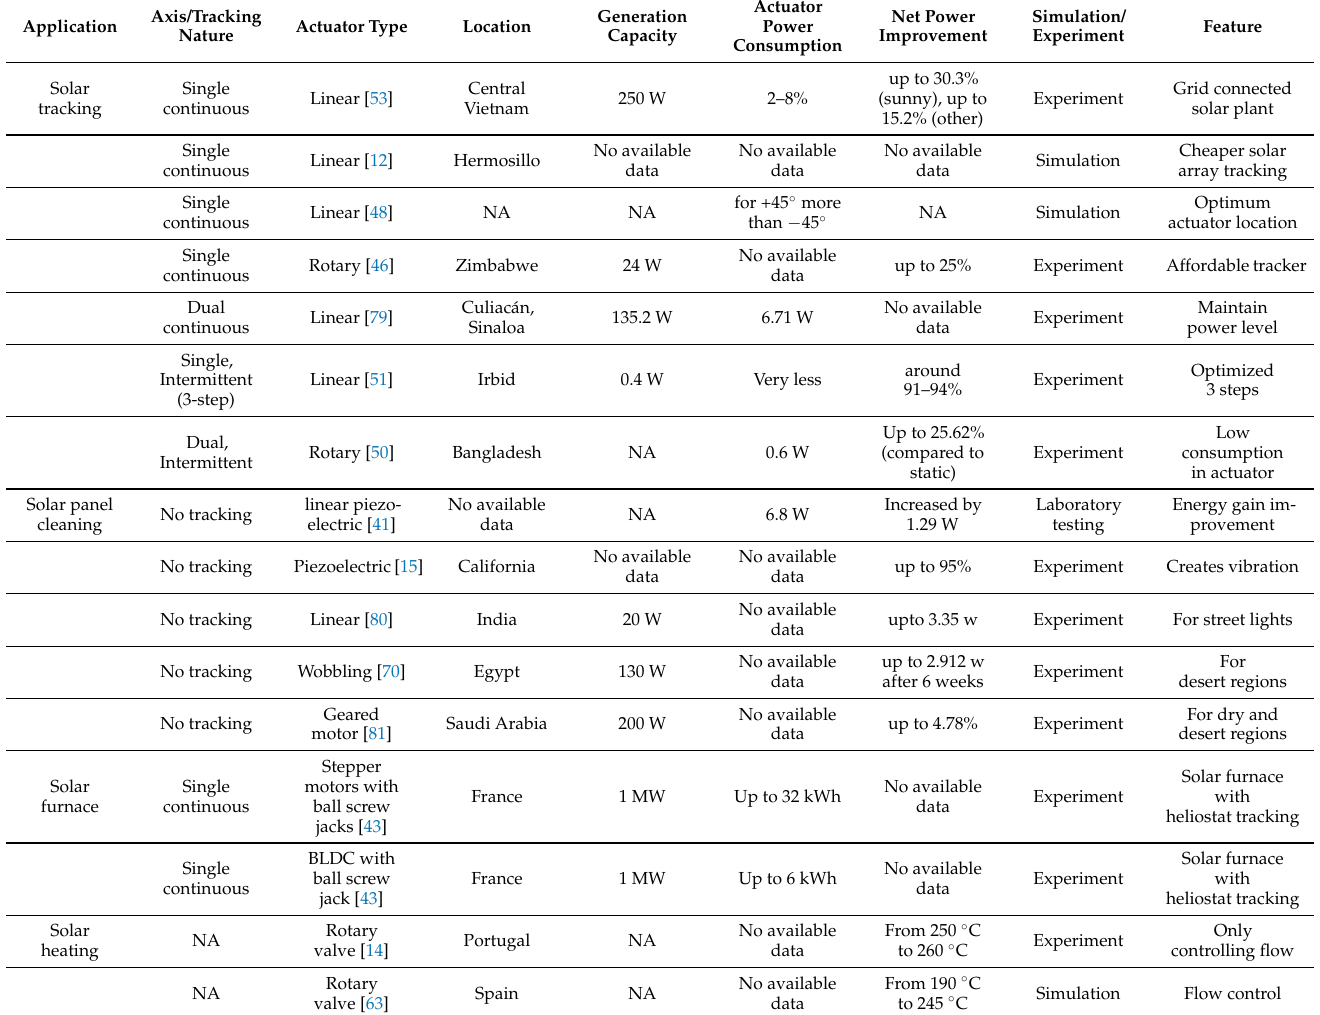
Table 3. Summary of actuator power consumption in different